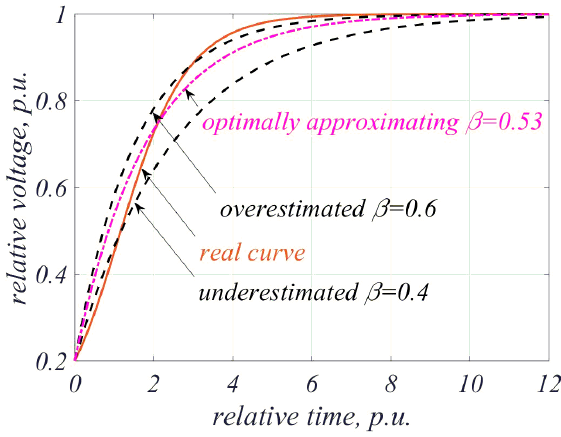
Figure 4. Voltage curves of a real dynamic process and its approximations: optimal β = 0.53, overestimated β = 0.60, and underestimated β = 0.40.